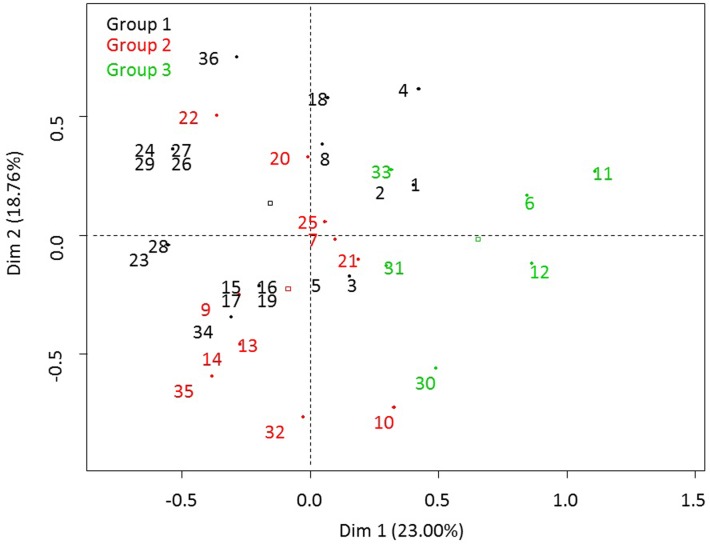
Ascending hierarchical classification of individuals (using the first 5 dimensions of multiple component analysis performed using data for 36 females with complete data) did not reveal any significant groups.